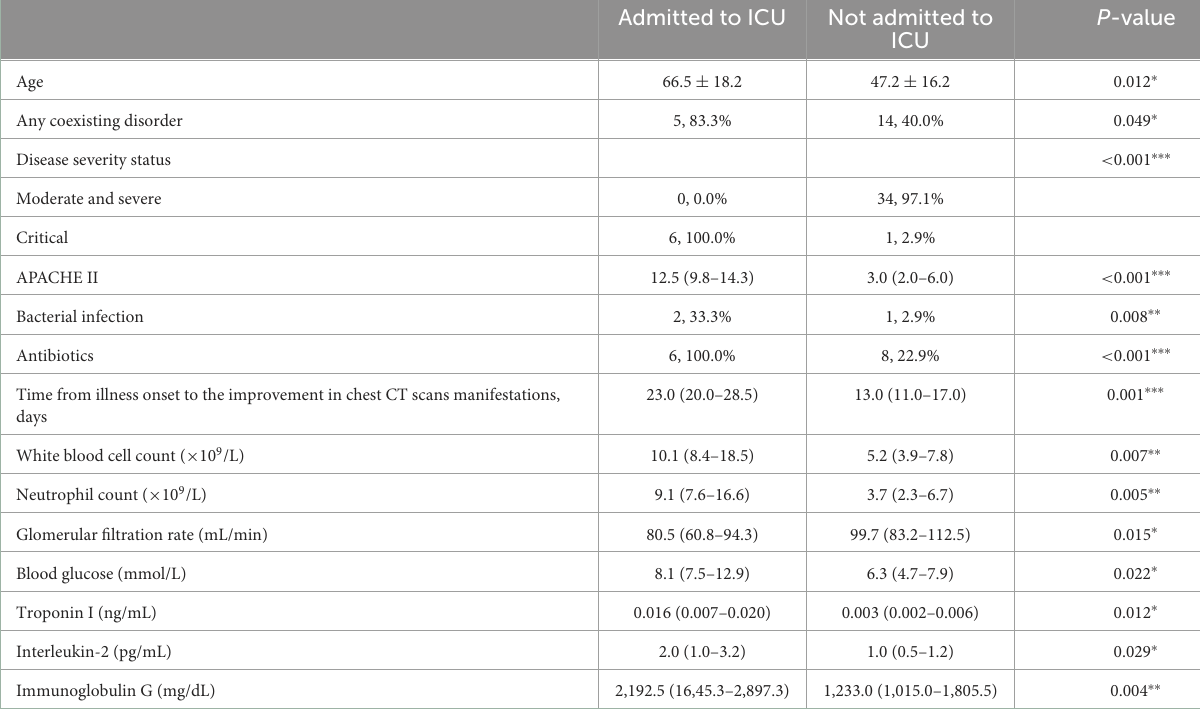
TABLE 4 Difference in clustered cases admitted or not admitted to